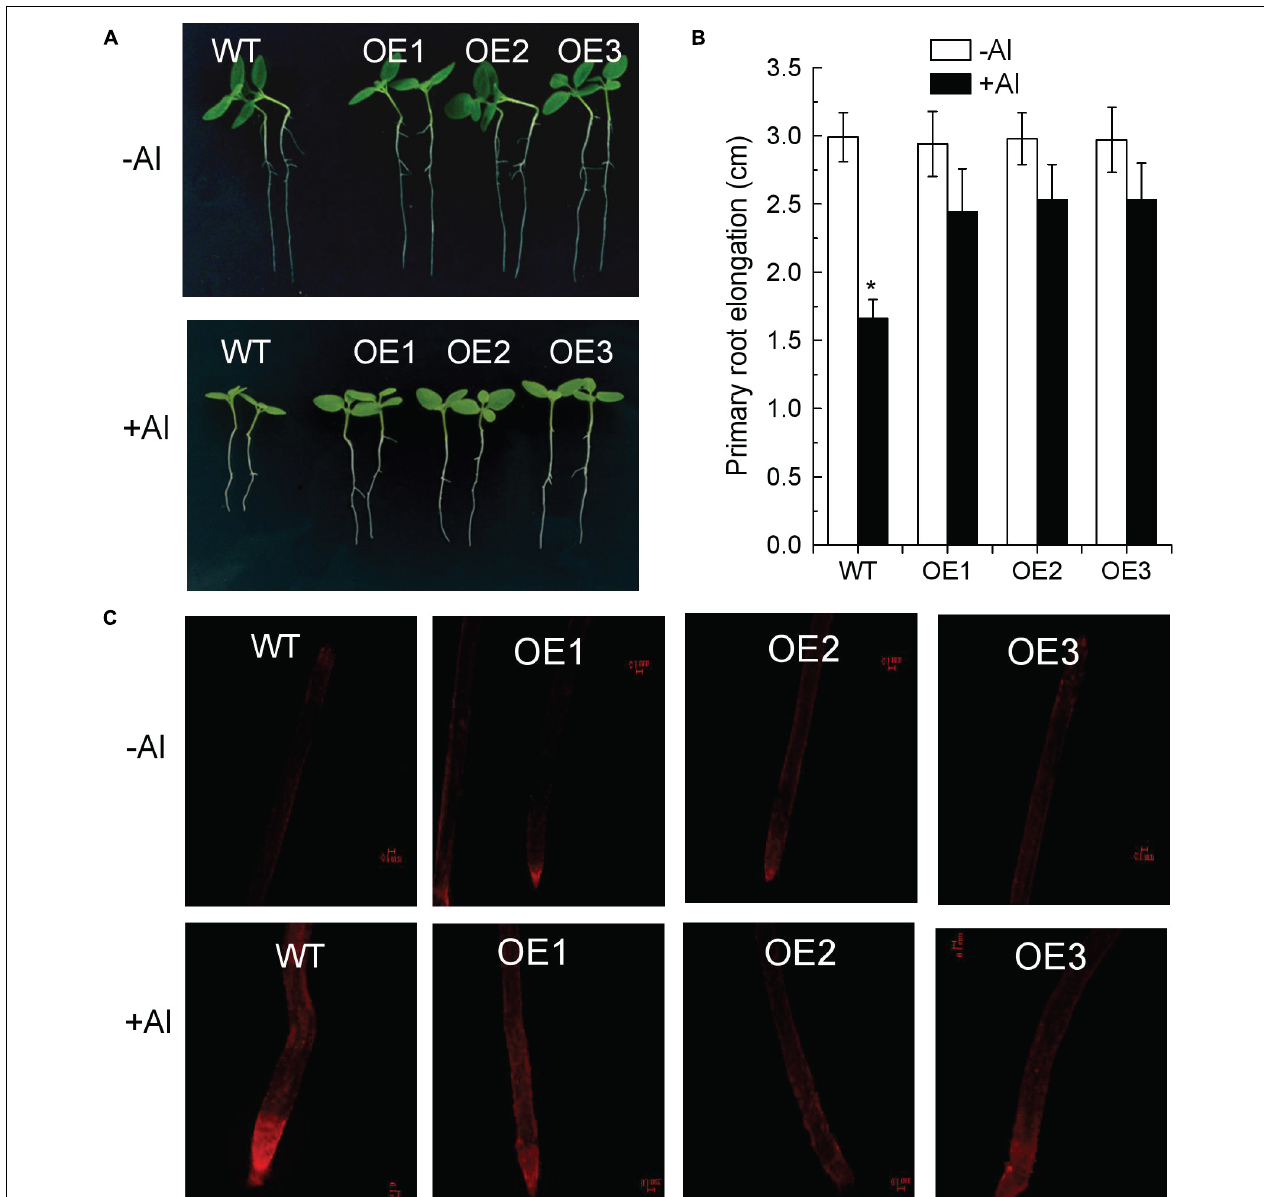
FIGURE 9 | Overexpression of SlAAE3-1 in tobacco improved Al tolerance. (A) Al tolerance phenotype of SlAAE3-1 overexpressing tobacco lines. (B) Primary root elongation. Data are the means ± standard deviation (SD) ( n = 10); the asterisk indicates significant differences between control and treatment at P < 0.001 using one-way ANOVA. (C) Propidium iodide staining, fluorescence signals were analyzed using confocal microscopy, bars = 100 µ